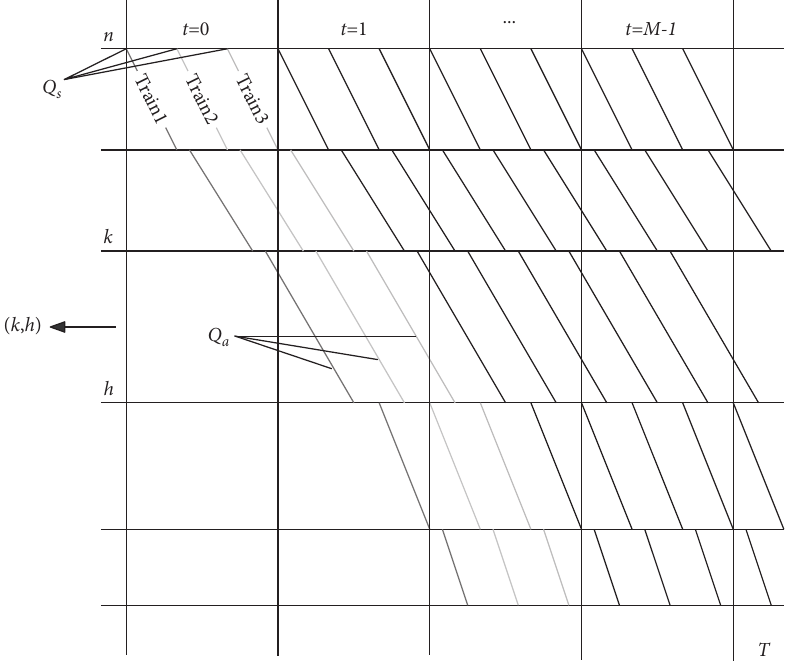
Figure 2: The schematic of the station-to-line spatial-temporal